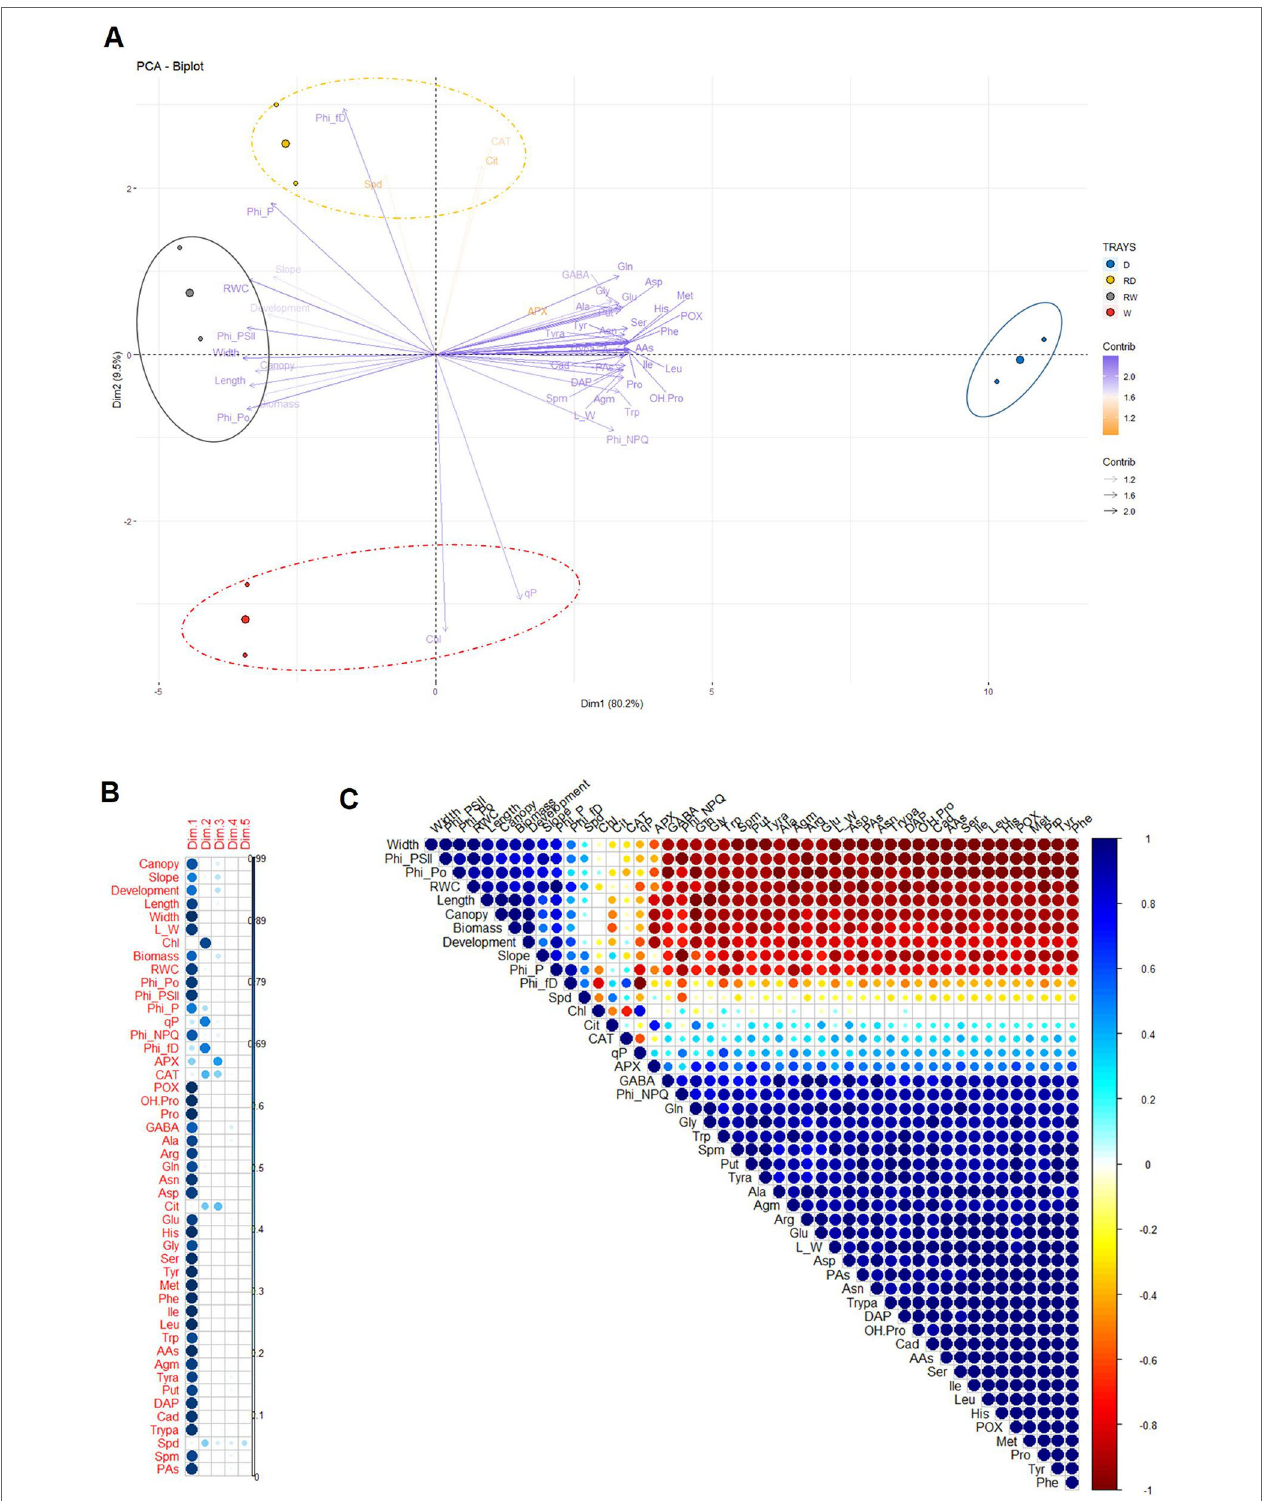
FIGURE 9 | Multivariate statistical analyses of the traits in barley seedlings related to the water stress response and subsequent rewatering. (A) Principal component (PC) analysis (B) contribution of the loadings to each PC (Dim) and (C) a correlation matrix of 47 variables, including 15 traits and 32 biochemical metabolites obtained from different biological replicates of two independent trays with barley seedlings at the end of the water stress period and after subsequent